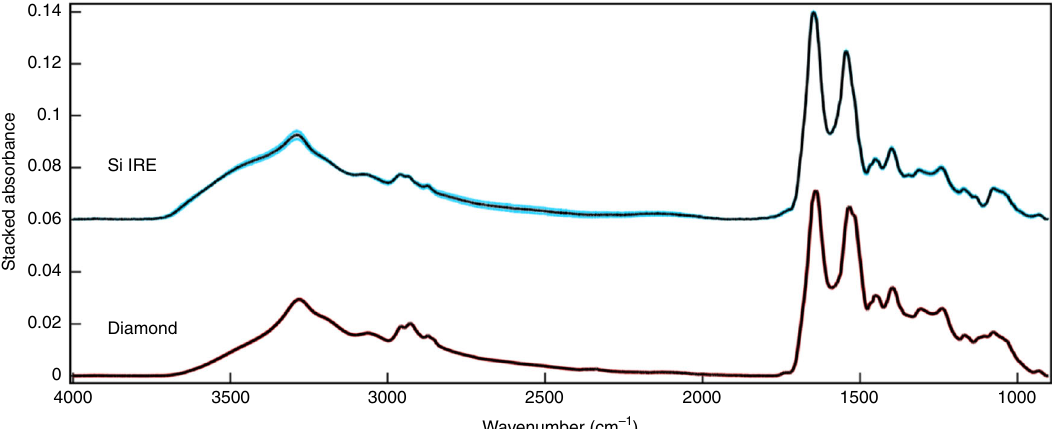
Fig. 4 Human pooled serum spectrum obtained from Si IRE ATR-FTIR spectroscopy. Coloured shading represents standard deviation of ten spectra derived from Si (blue) and diamond (red)